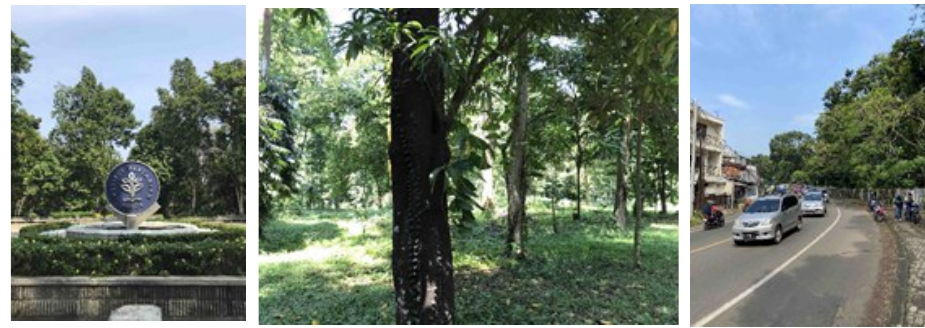
Figure 4. Geo-tagged Photographs. (a) Academic Event Plaza; (b) Arboretum; (c) Jalan Raya Dramaga.